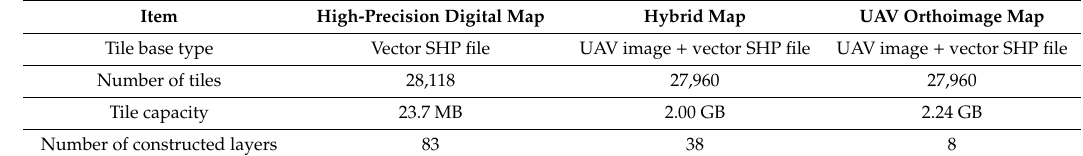
Table 4. Performance of the tile map.